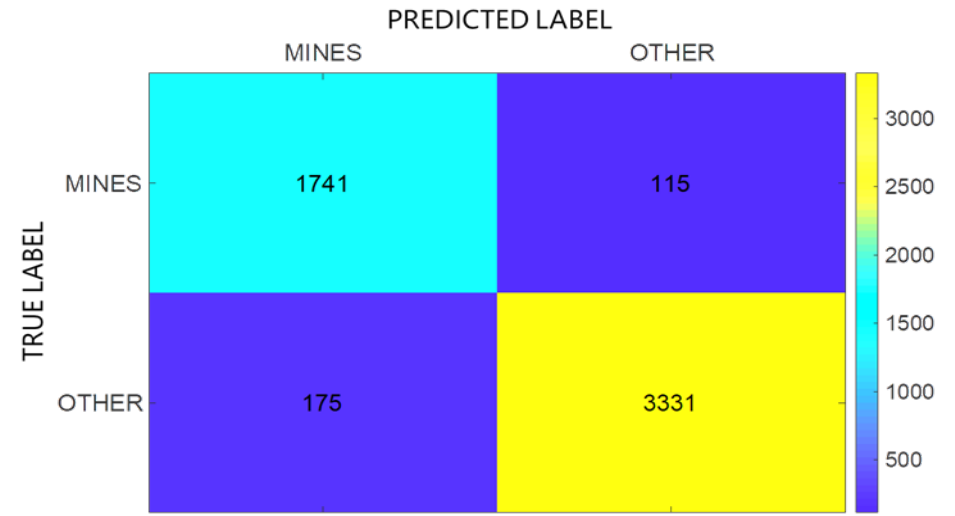
Figure 12. Confusion matrix of the detection algorithm for the Vegetation Monitoring Device (VMD).